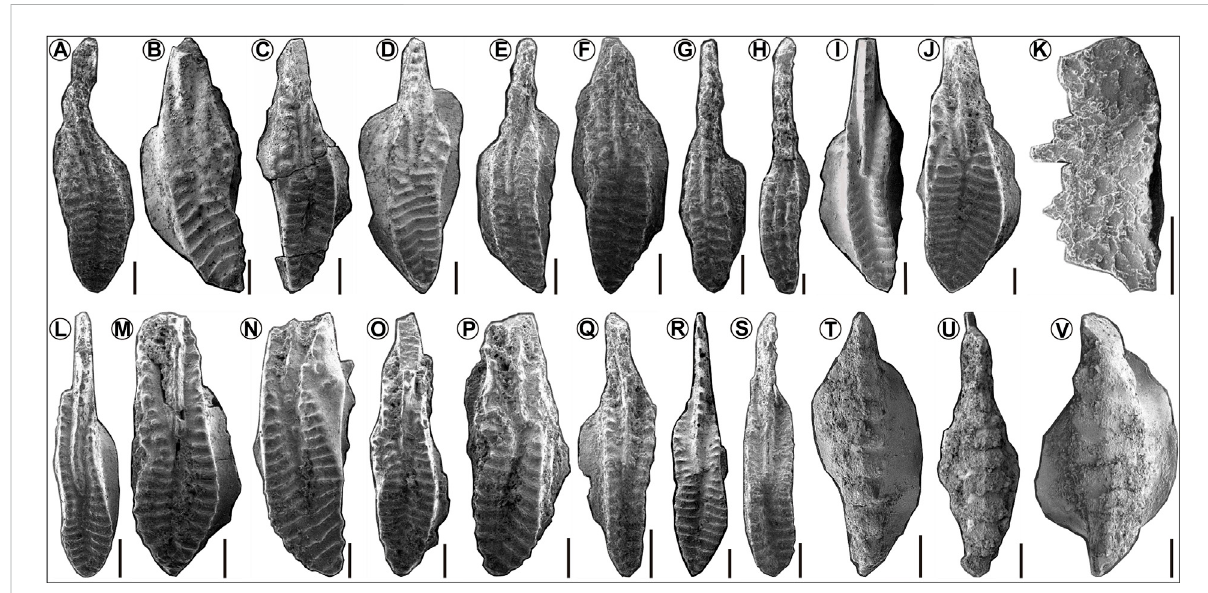
FIGURE 3 SEM images of example conodonts from limestones #L 1 , #L 2 , #L 3 , #L 4, and #L 8 in the study area (all scale bars = 100 μ m). (A – C) , Streptognathodus isolatus (#L 1 and #L 2 ) (D) , Streptognathodus wabaunsensis (#L 1 ) (E) , Streptognathodus elegantulus (#L 1 ) (F) , Streptognathodus gracilis (#L 1 ) (G) , Streptognathodus oppletus (#L 1 ) (H) , Streptognathodus parvus (#L 1 ) (I) , Streptognathodus ximplex (#L 2 ) (J) , Streptognathodus nodulinearis (#L 2 ) (K) , Hindeodus minutus (#L 1 ) (L) , Streptognathodus elongates (#L 2 ) (M – P) , Streptognathodus cristellaris (#L 3 ) (Q) and (R) , Streptognathodus constrictus (#L 4 ) (S) , Streptognathodus cf. constrictus (#L 4 ) (T) and (U ), Sweetognathus aff. whitei (#L 8 ) (V) , and Sweetognathus inornatus (#L 8